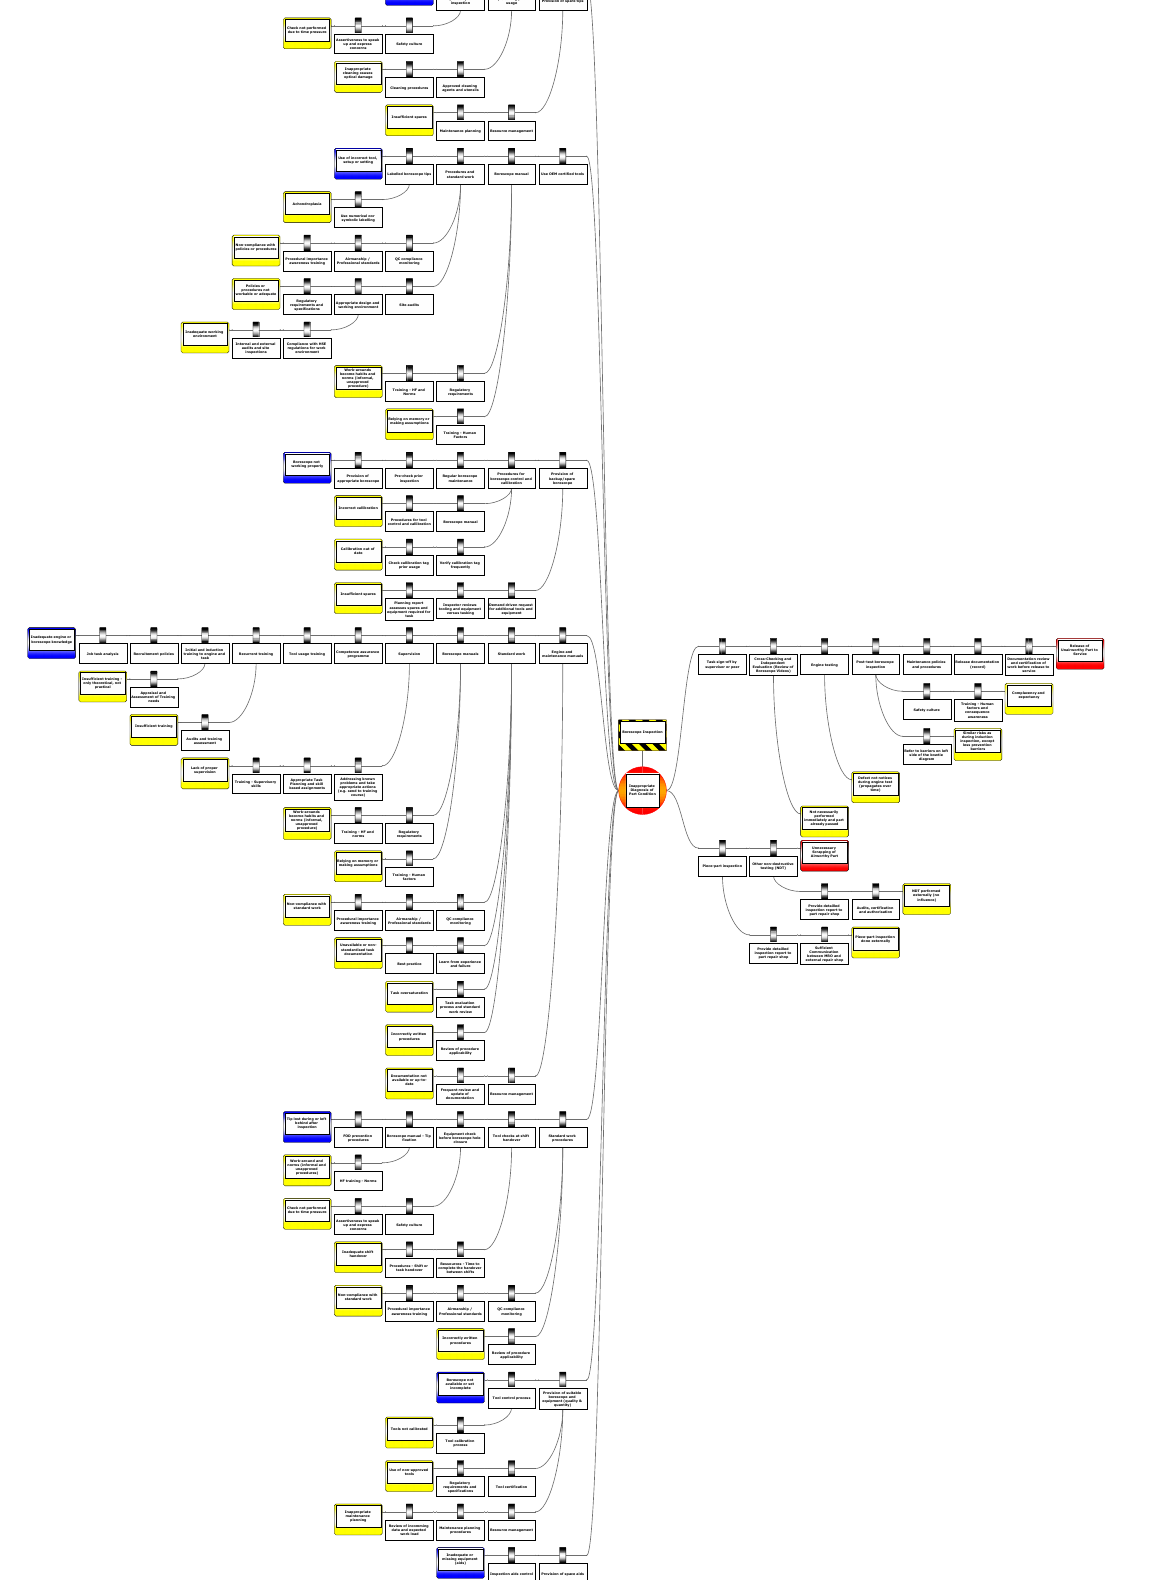
Figure A5. Complete Bowtie result with all elements.